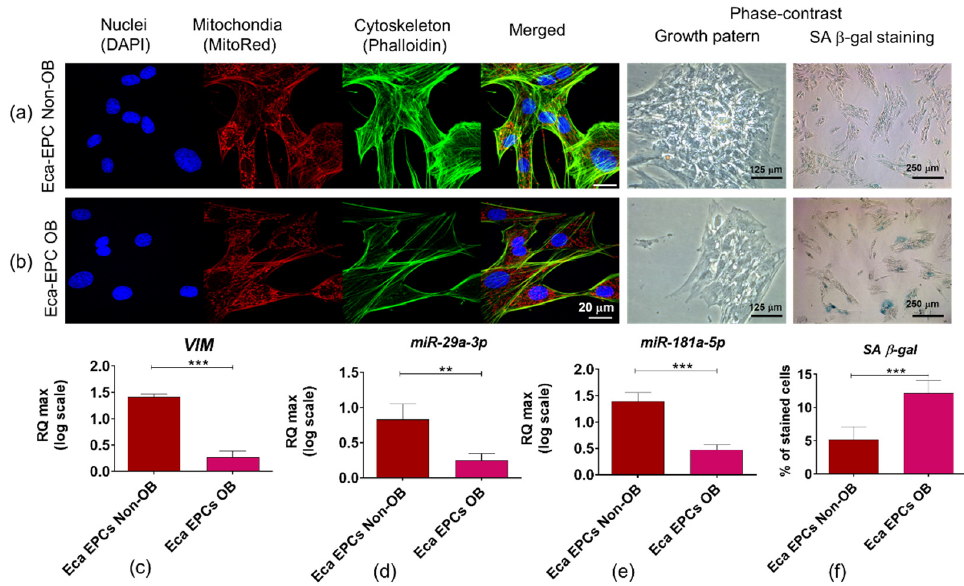
Figure 5. Morphology, ultrastructure, the growth pattern of equine endometrial progenitor cells (Eca EPCs) isolated from non-obese mares (non-OB) and obese mares (OB), and analysis of transcripts associated with a cytoskeletal network. The cultures were imaged with a confocal microscope to determine ultrastructure. Growth pattern of cell cultures was monitored under a phase-contrast microscope. Scale bars are indicated in the representative photographs ( a , b ). Additionally, RT-qPCR was performed to determine the mRNA expression of vimentin ( VIM ); ( c ) and levels of miR-29a-3p and miR-181-5p ( d , e ). Moreover, the senescence-associated β -Galactosidase (SA β -gal) was detected in cultures ( f ). Results are presented as a column with bars representing means ± SD. ** p -value < 0.01 and *** p -value < 0.001.